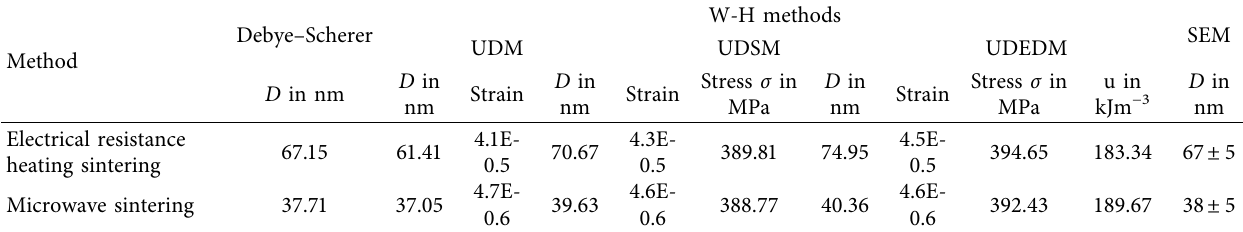
Table 1: Results of Debye–Scherrer, WH plots and SEM image